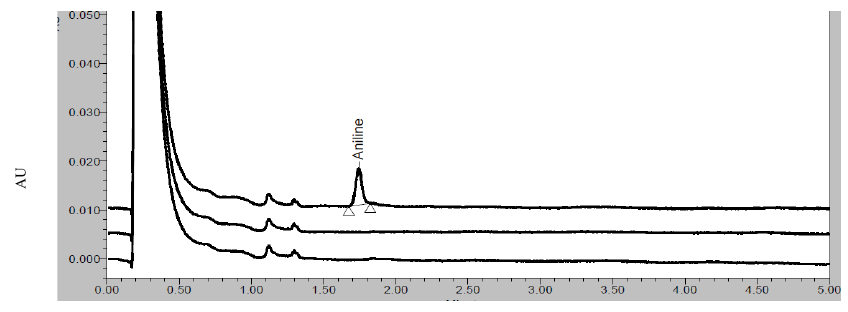
Figure 3. Overlay chromatogram of blank (bottom), placebo (middle) and standard preparation (top)